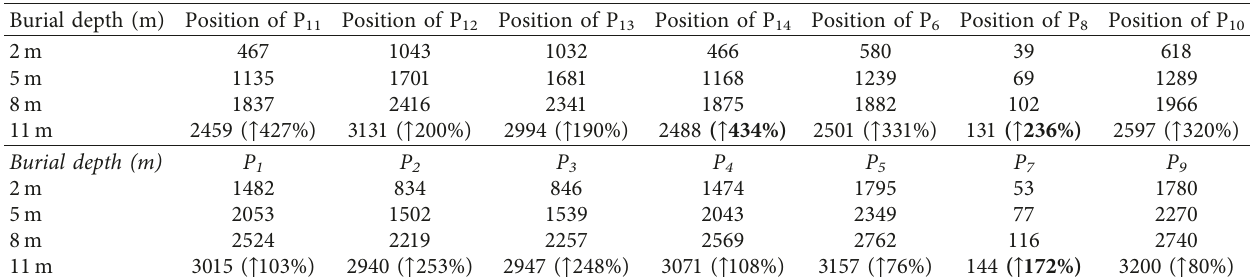
Table 3: The maximum shear forces of typical sections of the structure with different burial depths (unit: kN).